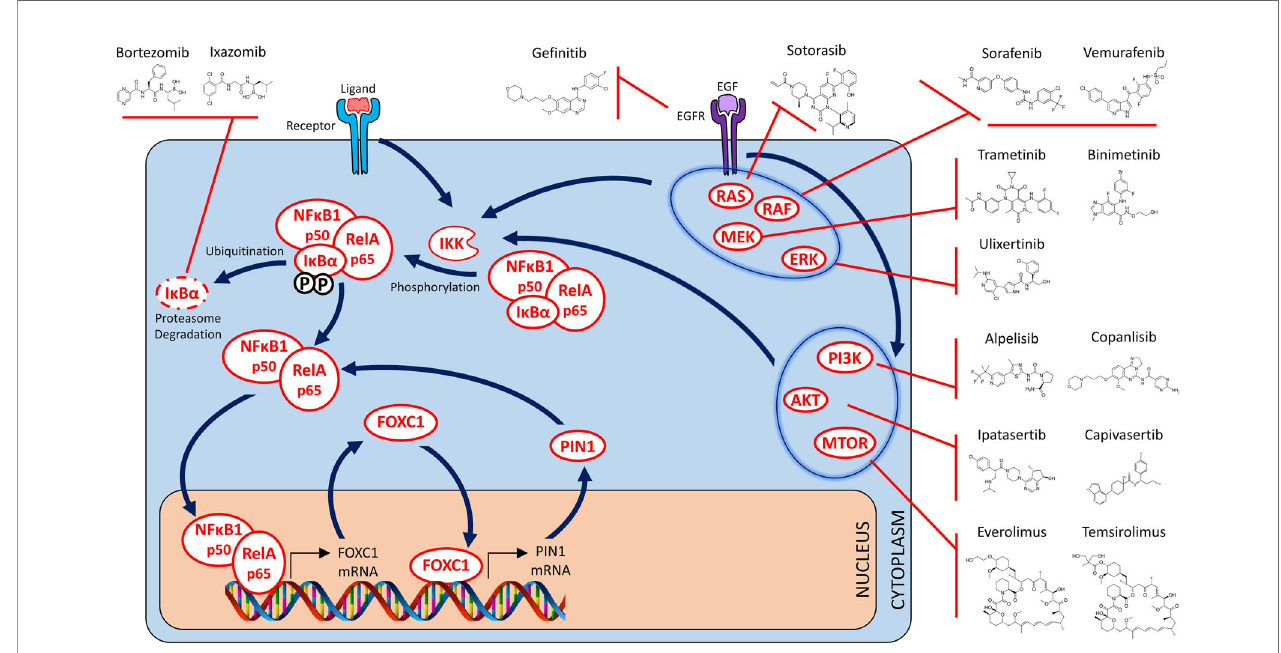
FIGURE 3 | Targeted NF ĸ B, RAS/MAPK and PI3K/AKT/MTOR therapy strategies for FOXC1-overexpressing prometastatic cancers – I. Drugs that target the NFkB signaling pathway (Binding of transcriptional coactivator and RNA polymerase to p50/p65 heterodimer not shown). Indirect targeting opportunities are also depicted where targeted inhibition of alternate signaling pathways effectively blocks activation of the NF ĸ B signaling pathway as well. These include targeting of the EGFR receptor, various members of the RAS/MAPK signaling pathway (including RAS, RAF, MEK and ERK), as well as the individual members of the PI3K/AKT/mTOR signaling